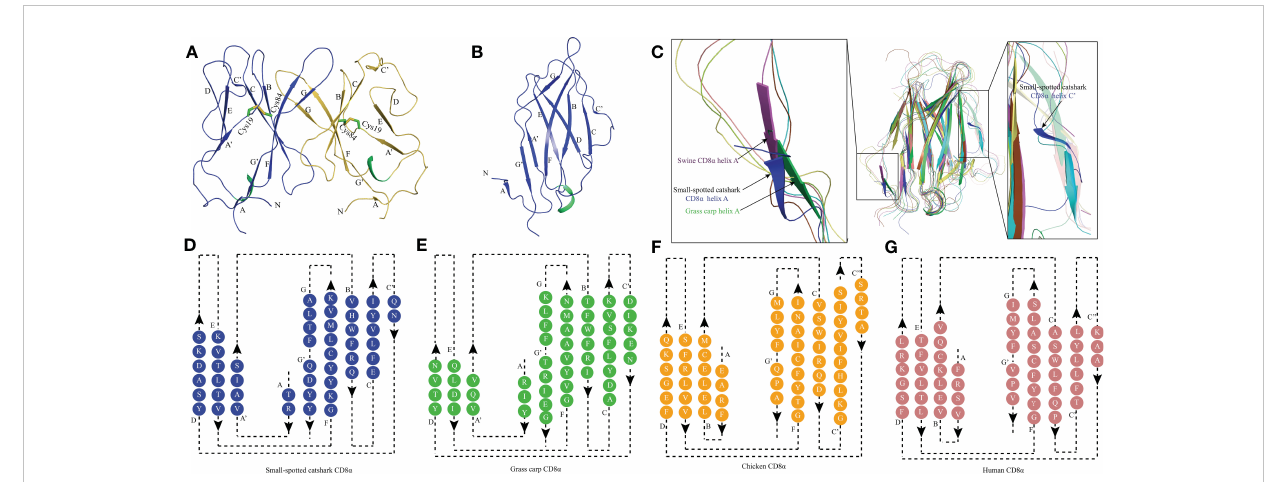
FIGURE 2 The topological structure of Sc CD8 aa extracellular region. (A) Cartoonstructure of the Sc CD8 aa homodimer, CD8 a monomers are colored blue and orange. The b -strands are labelled. Disul fi de bonds are shown as sticks and colored lime green. (B) The monomer structure of the Sc CD8 a extracellular region. (C) Comparison of Sc CD8 a extracellular region to that of other species. All the structures are shown in cartoon representation. The Sc CD8 a is colored blue, grass carp CD8 a is lime green, chicken CD8 a is yellow, bovine CD8 a is cyan, human CD8 a is pink, mouse CD8 a is orange, monkey CD8 a is limon, and swine CD8 a is light magenta. Helix A of Sc CD8 a , swine CD8 a , and grass carp CD8 a are labeled. Helix C ’ of Sc CD8 a is labeled in the righthand panel. PDB accession numbers for each structure are as follows; human CD8 aa 1CD8, chicken CD8 aa 5EB9, swine CD8 aa 5EDX, grass carp CD8 aa 5Z11, monkey CD8 aa 2Q3A, mouse CD8 aa 2ARJ and bovine CD8 aa 5EBG. (D-G) Two-dimensional topology diagrams of vertebrate CD8 a s. The strands form a sandwich of 2 sheets in the catshark, grass carp, chicken, and human, which are colored blue, lime green, orange, and pink respectively, b -strands are labeled.